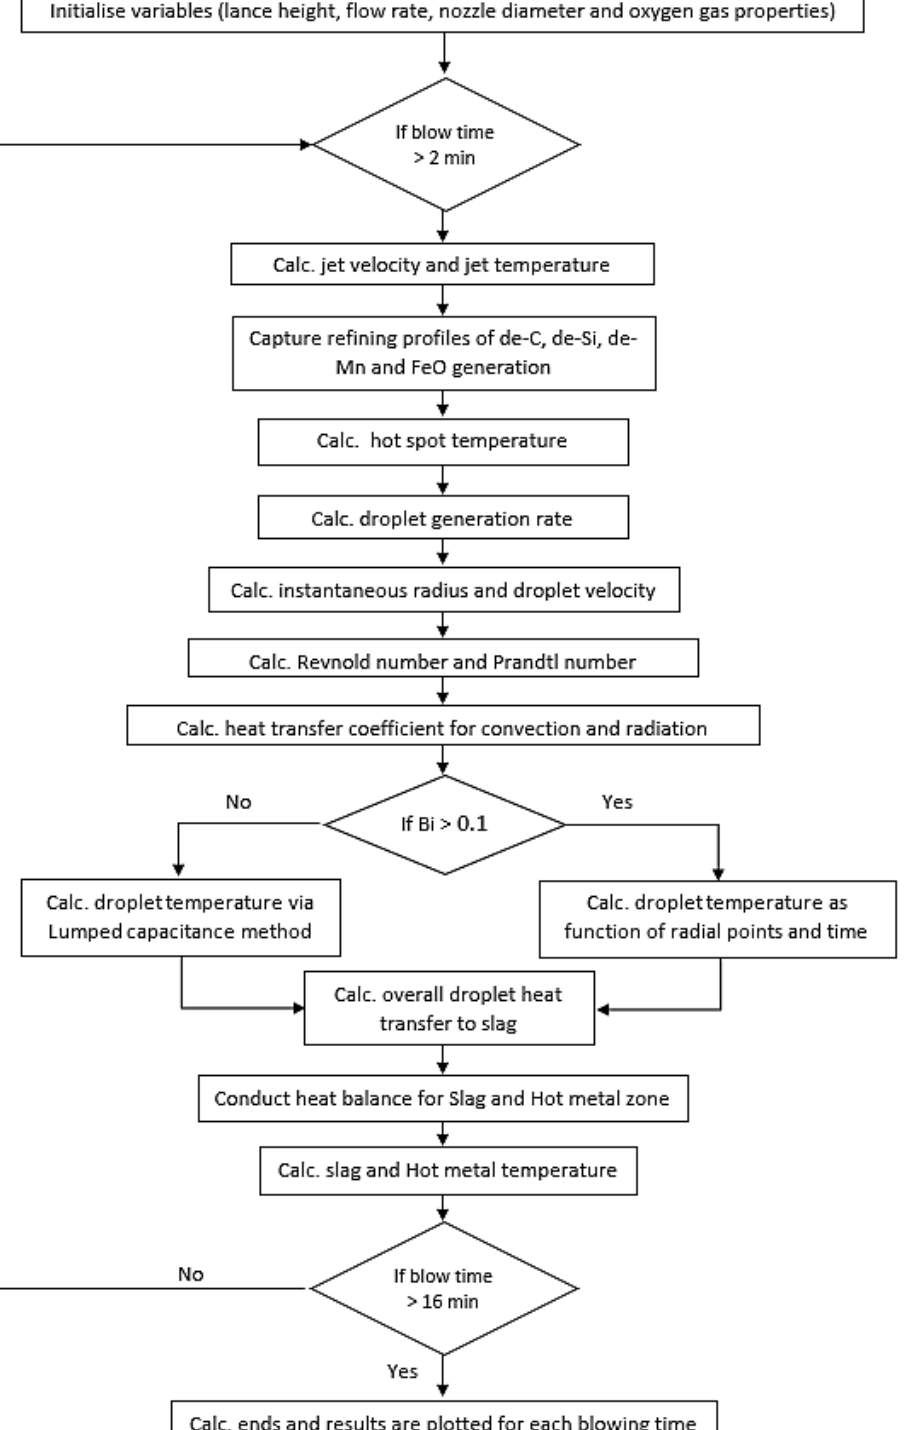
Figure 2. Algorithm for global droplet heat transfer model.